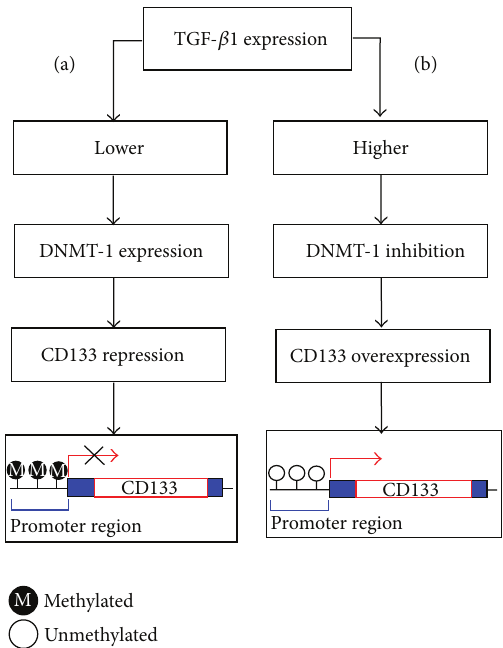
Figure 2: A schematic presentation elaborating epigenetic regu- lation of CD133 by TGF- 𝛽 1 mediated by DNA methyltransferase (DNMT-1) in Huh 7 cell (HCC cell line). (a) Low expression of TGF- 𝛽 1doesnotaffectDNMT-1andthusmethylationofCD133promoter is maintained. (b) Elevated expression of TGF- 𝛽 1 inhibits DNMT-1 which results in demethylation of CD133 promoter resulting in the initiation of